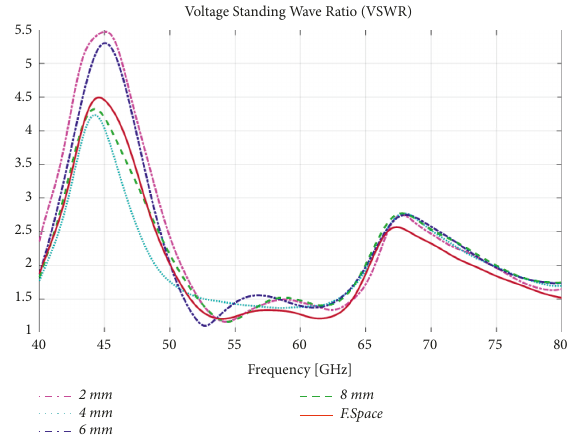
Figure 41: VSWR of the1x2 array antenna for different distances.